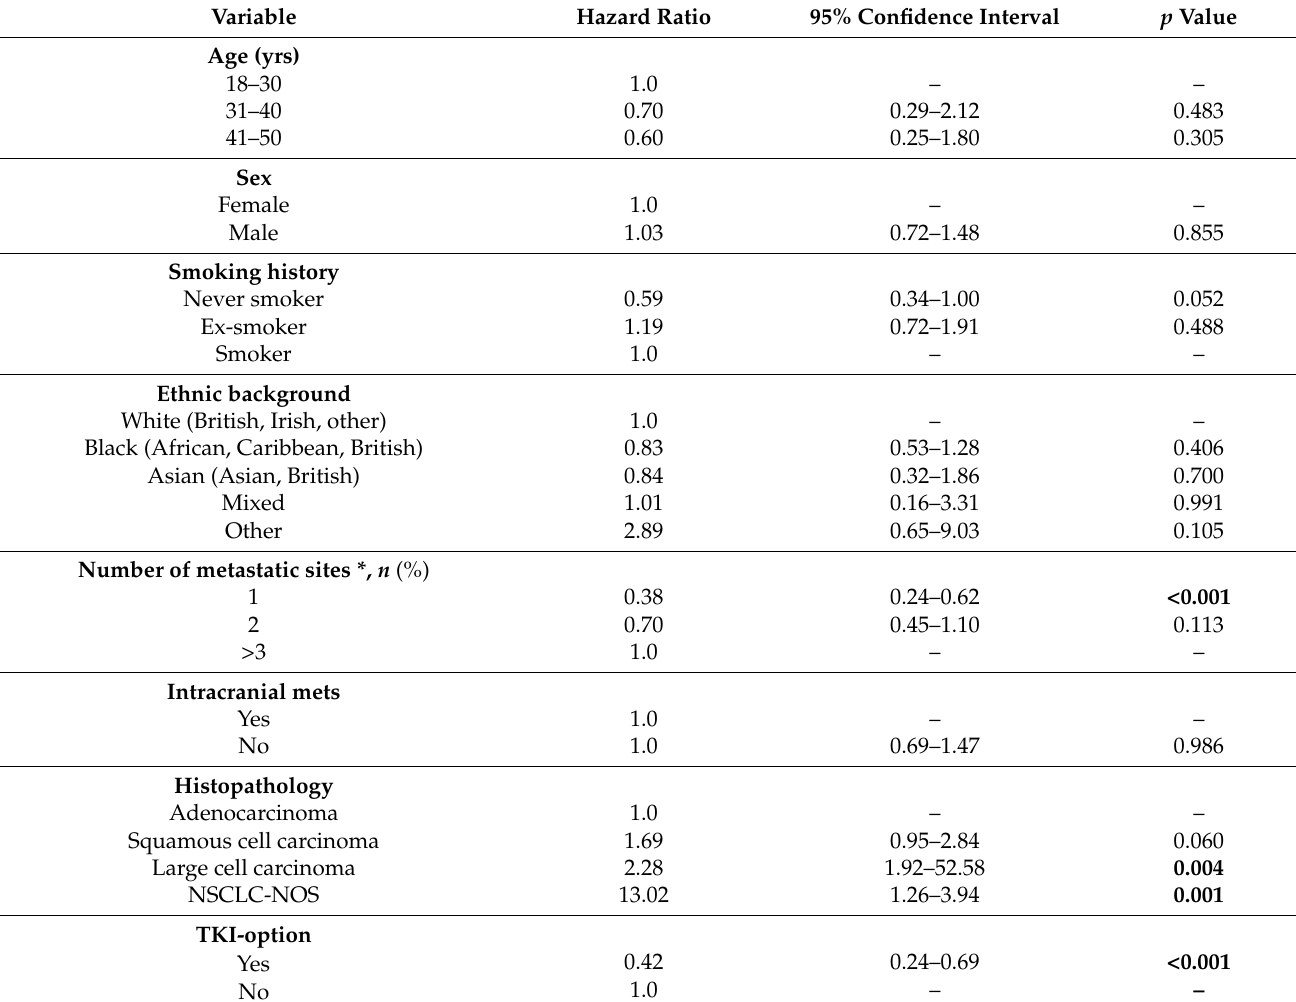
Table 4. Multivariate analysis of survival in of all metastatic NSCLC patients ( n = 199; at diagnosis or developed metastatic